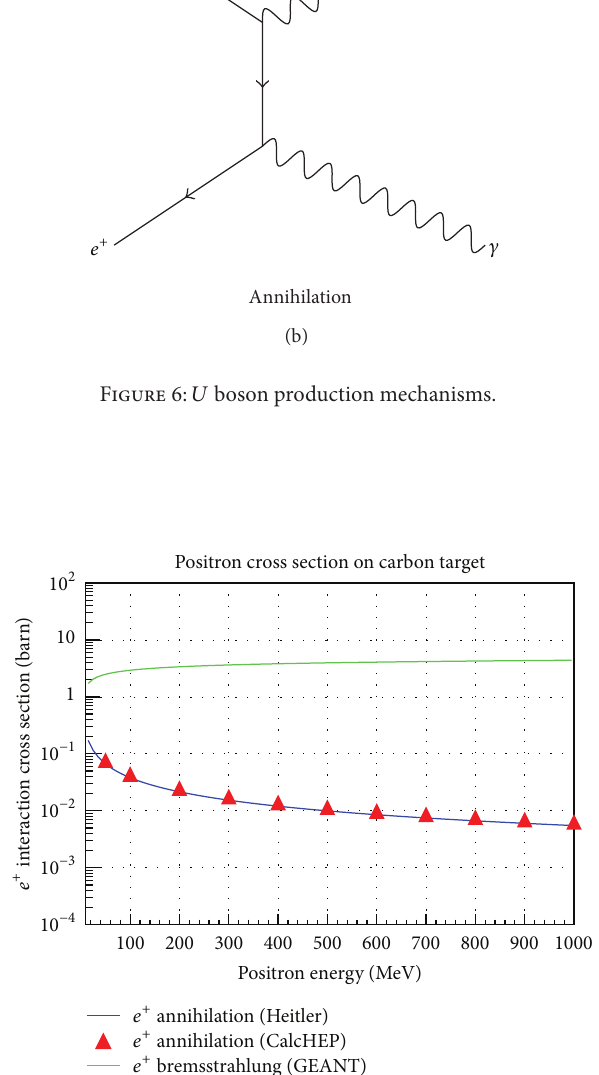
Figure 7: Positron cross section on a carbon target.